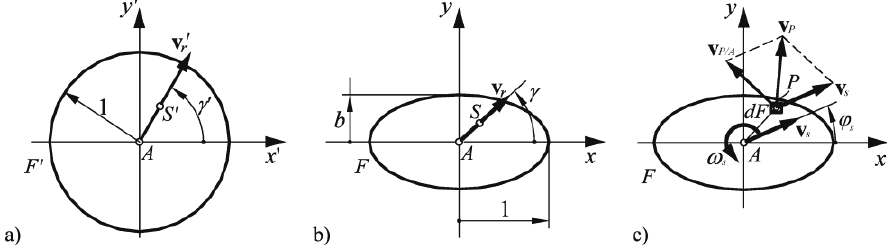
Fig. 2. Elliptic contact area between two bodies with the co-ordinate